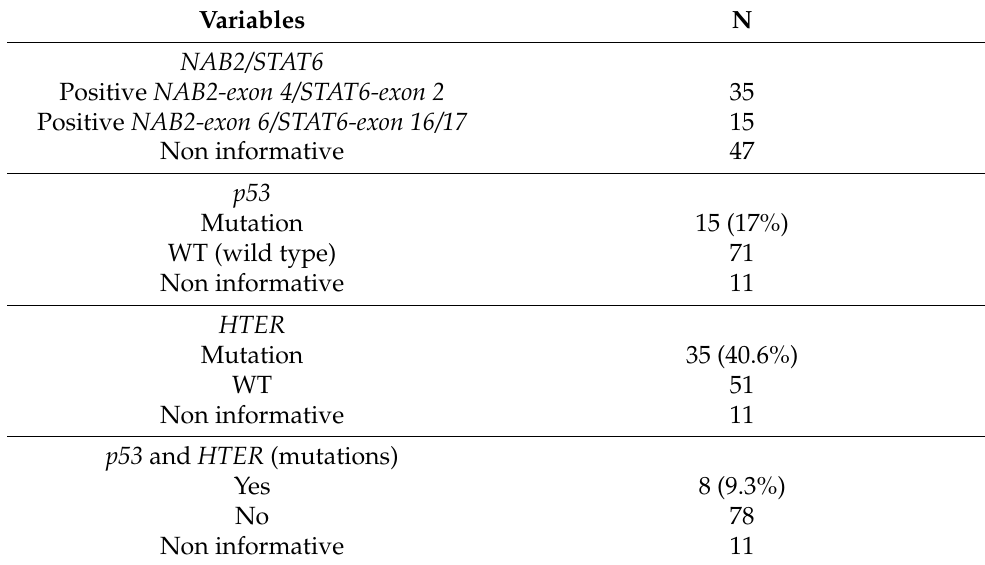
Table 5. Solitary fibrous tumor, molecular results (N = 97).